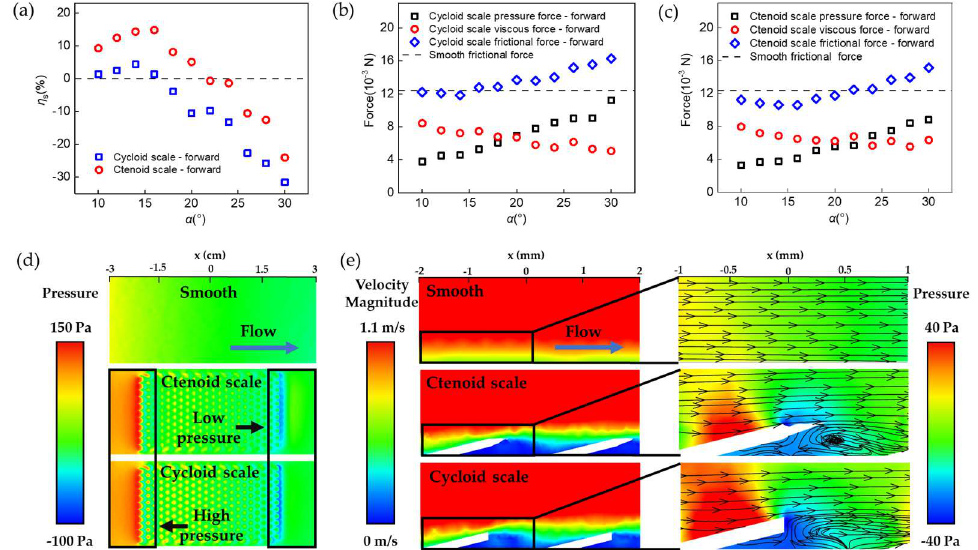
Figure 3. Numerical simulations of the drag reduction mechanism of BFTSS. ( a ) Simulated forward drag reduction rate for different surfaces with varying α . ( b ) Forces on single-tier cycloid scales with in forward flow. ( c ) Forces on BFTSS with in forward flow. ( d ) Pressure distribution on different surfaces in forward flow. ( e ) Velocity vector and streamline plots of different surfaces in forward flow.